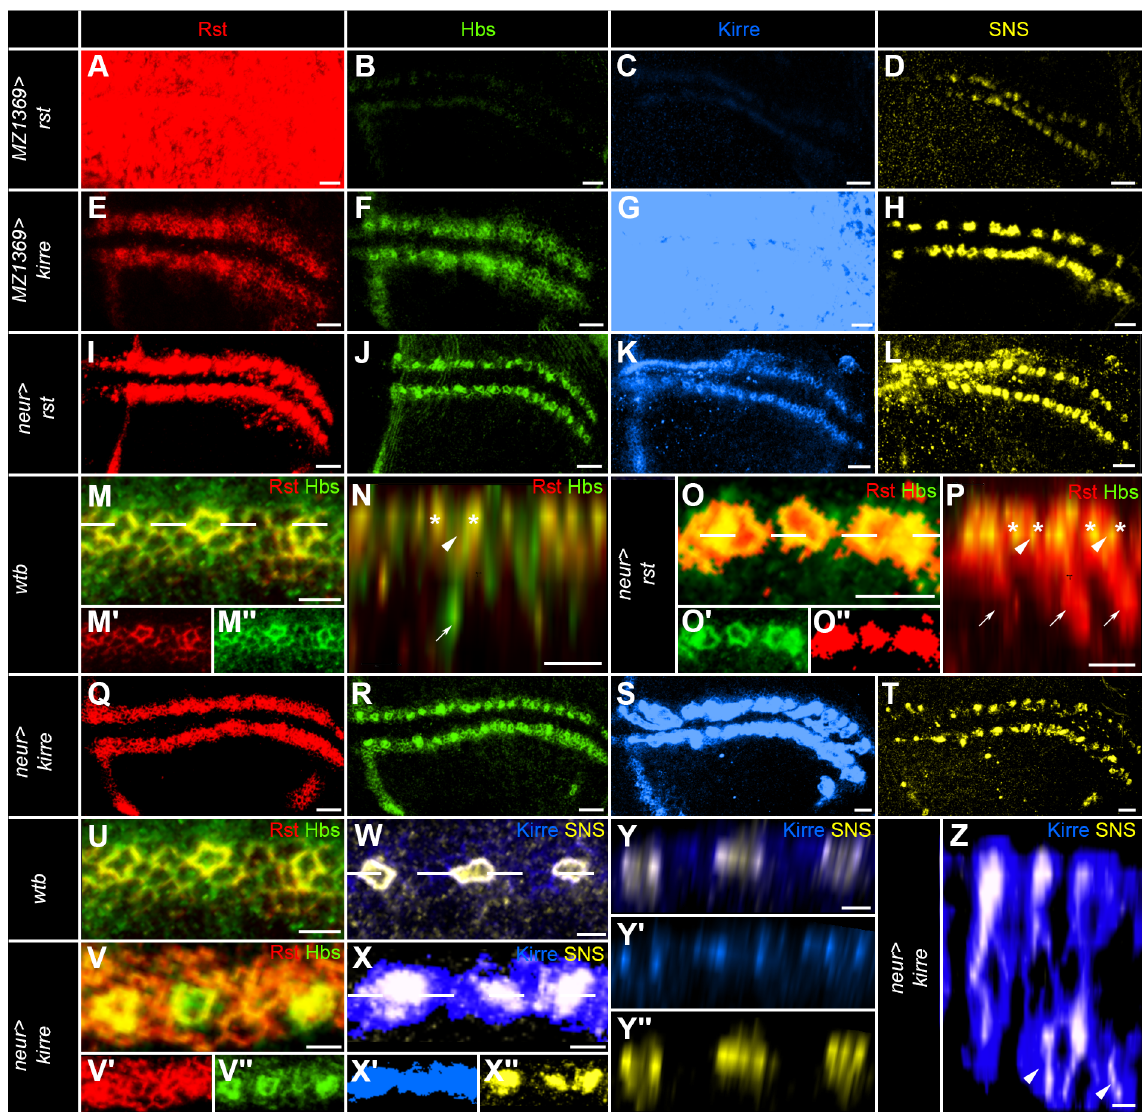
Fig 4. The Neph-like proteins Rst and Kirre affect the localization of other IRM members in cis and trans . (A-M, O, Q-X) Projection views of IRM immunoreactivity in third instar larvae. Rst is shown in red (A, E, I, M-Q and U-V), Hbs in green (B, F, J, M-P, R and U-V), Kirre in blue (C, G, K, S and W-Z) and SNS in yellow (D, H, L, T and W-Z). (A-D) Misexpression of rst using MZ1369-GAL4 leads to ubiquitous Rst staining (A) in the entire wing disc. Hbs (B) and Kirre (C) are significantly reduced. SNS (D) staining is unaffected in strength, but the localization is not limited to the apical contact zone of the SOPs. Instead it is found in the entire cell. Additionally, the order of the SOPs is severely disturbed. (E-H) Misexpression of kirre via MZ1369-GAL4 leads to wider stripes of Rst (E) and Hbs (F) staining. Kirre (G) can be ubiquitously detected in the entire wing disc. SNS (H) staining is strong on all membranes in contact with Kirre positive membranes. Spacing of SOPs is already disrupted at this developmental stage. (I-L) Misexpression of rst using neur-GAL4 leads to strongly stained Rst (I) positive SOPs. Hbs (J) is found only around the SOPs and staining of membranes not in contact to the SOPs is reduced. (K) Kirre staining is further enriched around the SOPs. (L) SNS is relocated and it is not specifically located at the adherens junction any more. (M) Magnification of three SOPs of a wild type control stained for Rst and Hbs. The dashed line shows the approximate area of cut for the Z-projection in (N). Hbs can be detected inside the SOPs (arrowhead) and also in the basal appendix (arrow). (O) Magnification of three SOPs in neur-GAL4 > UAS-rst . The approximate area of cut for the Z-projection in (P) is given with a dashed line. Arrowheads mark the immunopositive interior of the SOPs showing strong Rst staining. Arrows marks the basal appendix of the SOPs. Asterisk mark the co-localization of Rst and Hbs immunoreactivity at the Border of SOPs. (Q-T) Misexpression of kirre using neur-GAL4 leads to strong Rst staining around the SOPs. Hbs (R) is found much stronger around or in the SOPs and is strongly reduced on the membranes not in contact with any SOPs. (S) Kirre staining is strongly found in all membranes of the SOPs, showing no apical-basal polarity. (T) SNS localization inside the SOPs is disrupted and a possible degradation product can be found in vesicles basal of the adherens junction. (U) Magnification of three SOPs of a wild type control stained for Rst and Hbs. (V) Magnification of three SOPs in neur-GAL4 > UAS-kirre . Strong accumulation of Hbs immunoreactivity is evident around the SOPs. (W) Magnification of three SOPs of a wild type control stained for Kirre and SNS. (X) The magnification of three SOPs of neur-GAL4 > UAS- kirre shows the strong Kirre staining in the entire SOP and the mislocalization of SNS. A dotted line in (W and X) shows the approximate area of a Z-cut that is